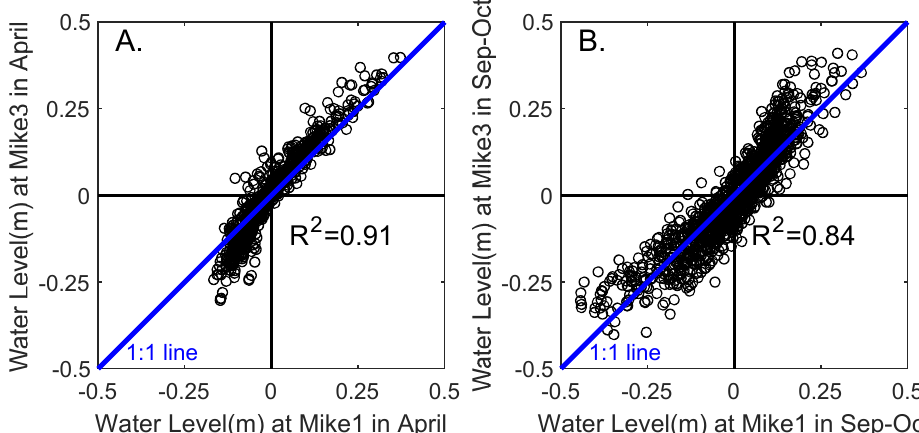
Figure 7. Coefficients of determination (R 2 ) between Mike1 and Mike3 water levels in April ( A ) and September–October ( B ) 2015. Mike1 and Mike3 are 1.5 km apart and their water levels are generally tightly coupled.